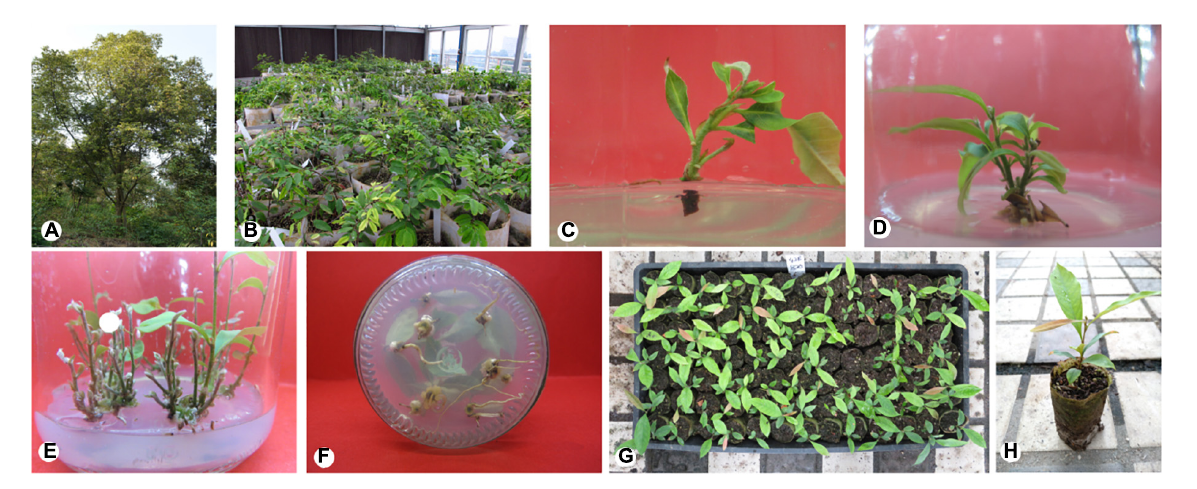
FIGURE2 Micropropagation of mature Castanopsis hystrix trees using axillary node explants. (A) Mother plant; (B) the miniature grafting nursery; (C) shoot sprouting; (D,E) shoot proliferation; (F) rooting; (G) plantlet acclimatization for 30 days; (H) plantlet acclimatization for 90 days.